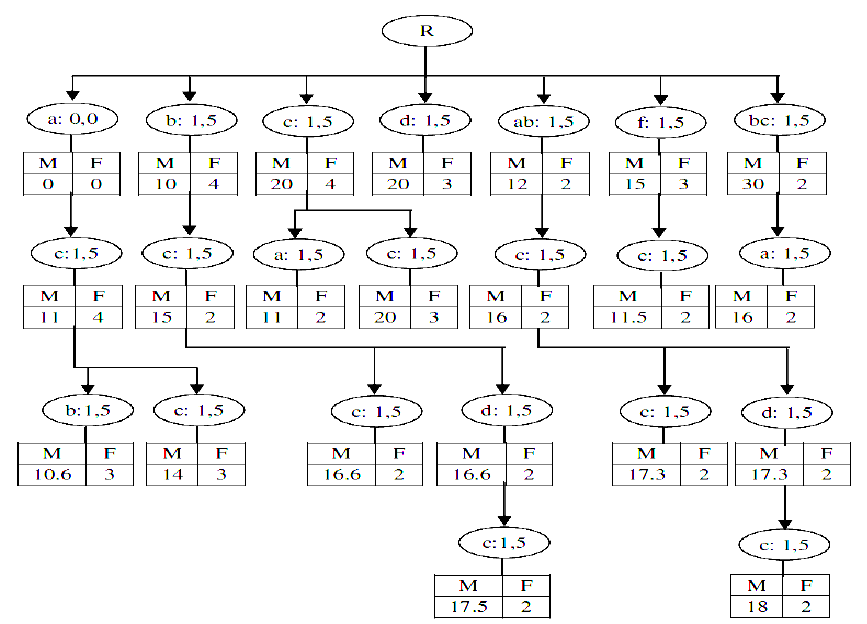
Fig.1. CFM-Pattern Tree for the Static